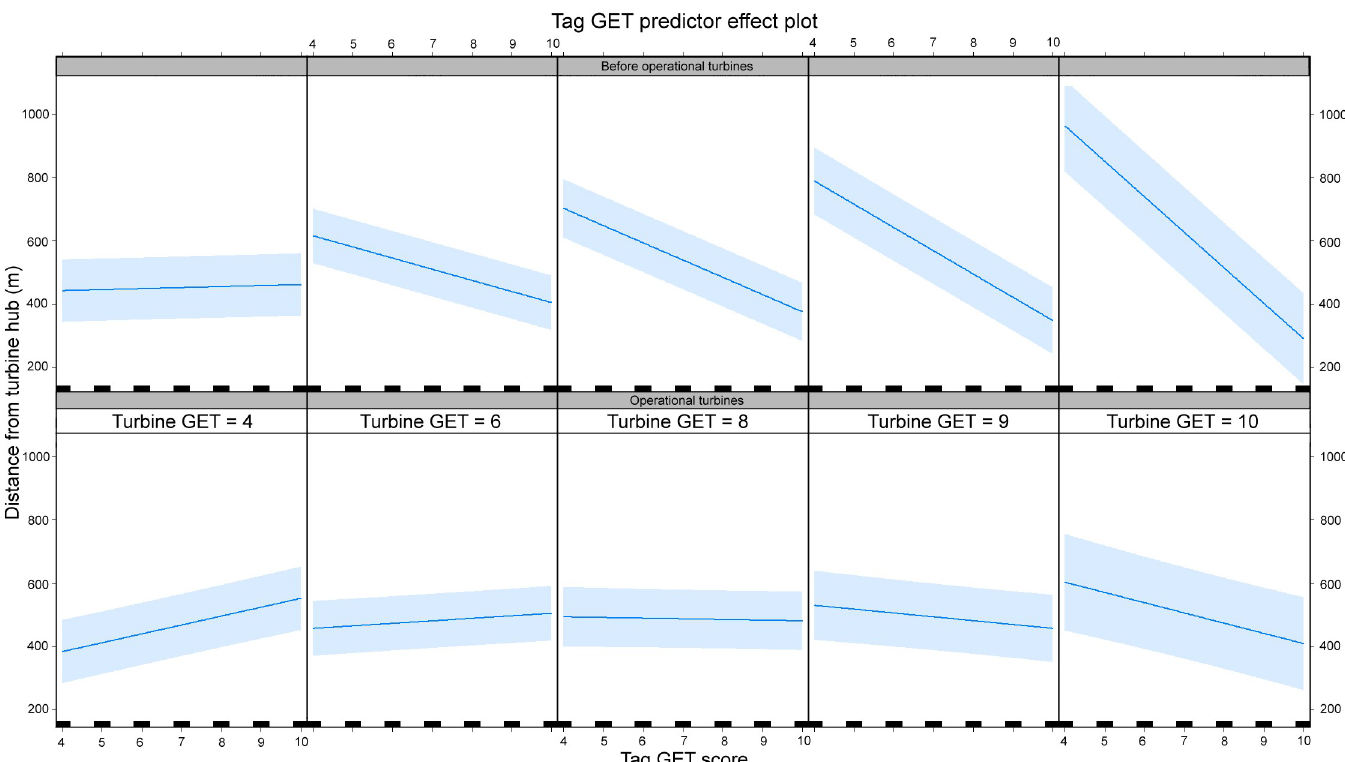
Fig 3. Tag GET effect plot showing the relationship between the fitted distance to the nearest turbine hub (y) and the GET score at a bird’s location. The upper row shows the relationships before turbines became operational and the lower row shows the relationships after turbines became operational. The panels show how the relationship is conditional on the GET score at the nearest turbine’s location. Blue lines and blue shading show the mean and 95% CL ranges, respectively.